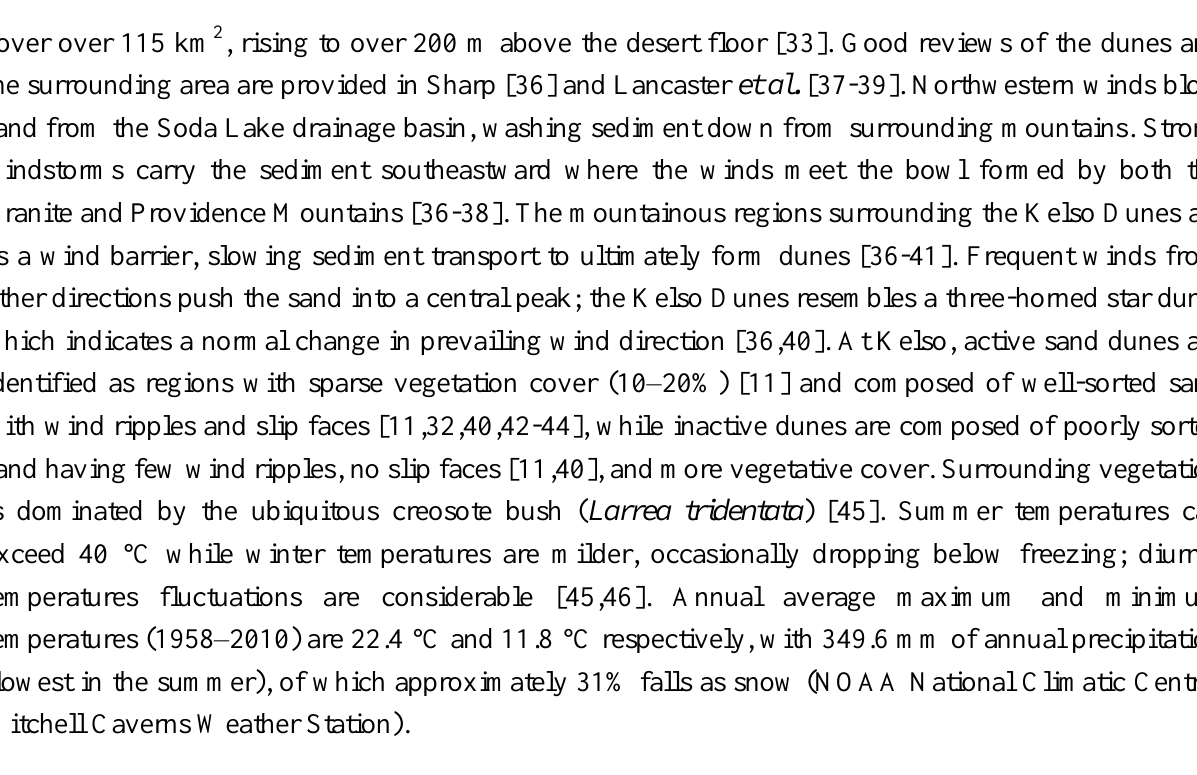
Figure 2. Kelso Dunes is located in southeastern California, USA in the Mojave National Preserve, neighbouring the Devils